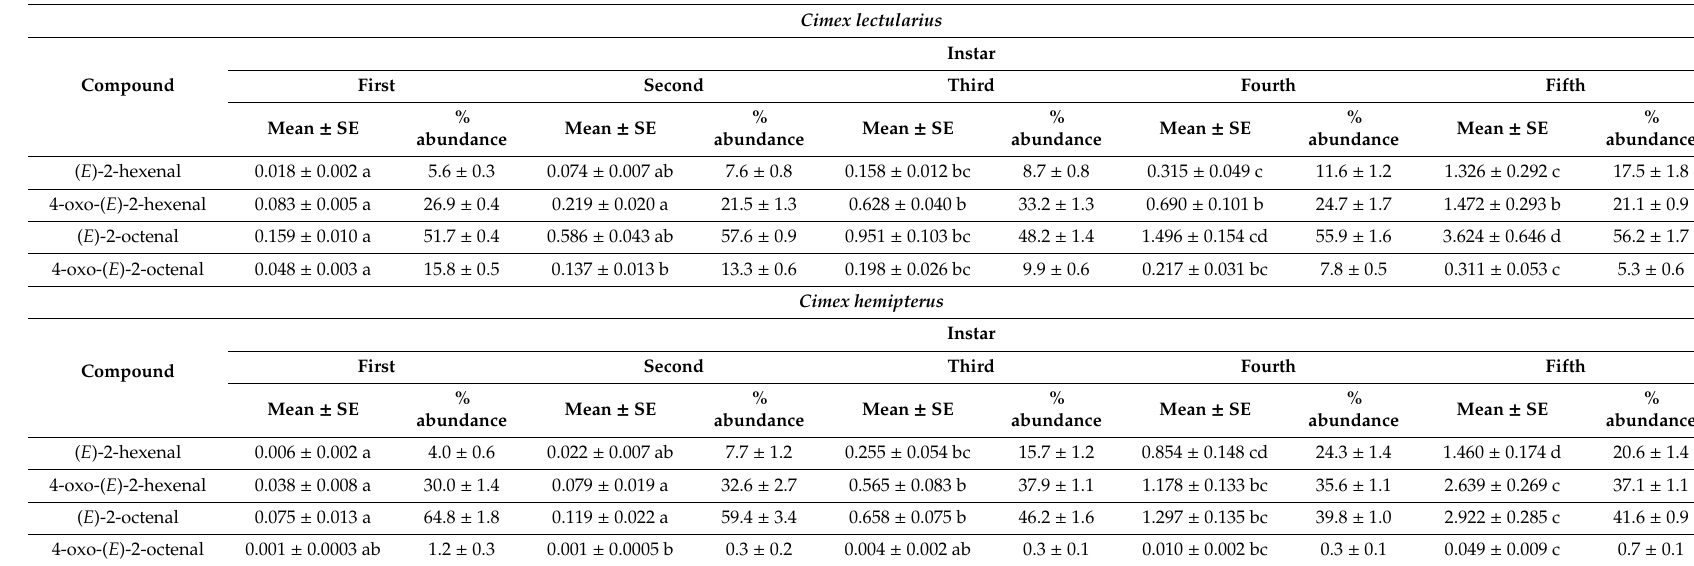
Table 1. Mean quantity ( µ g / exuvia; n = 10) and percent abundance (mean ± SE) of four aldehydes detected in freshly shed exuviae of first through fifth instar Cimex lectularius and Cimex hemipterus nymphs. Di ff erent letters across rows indicate significance di ff erences in each compound across the five instars ( p < 0.05; Dunn’s Multiple Comparisons) (SE = Standard